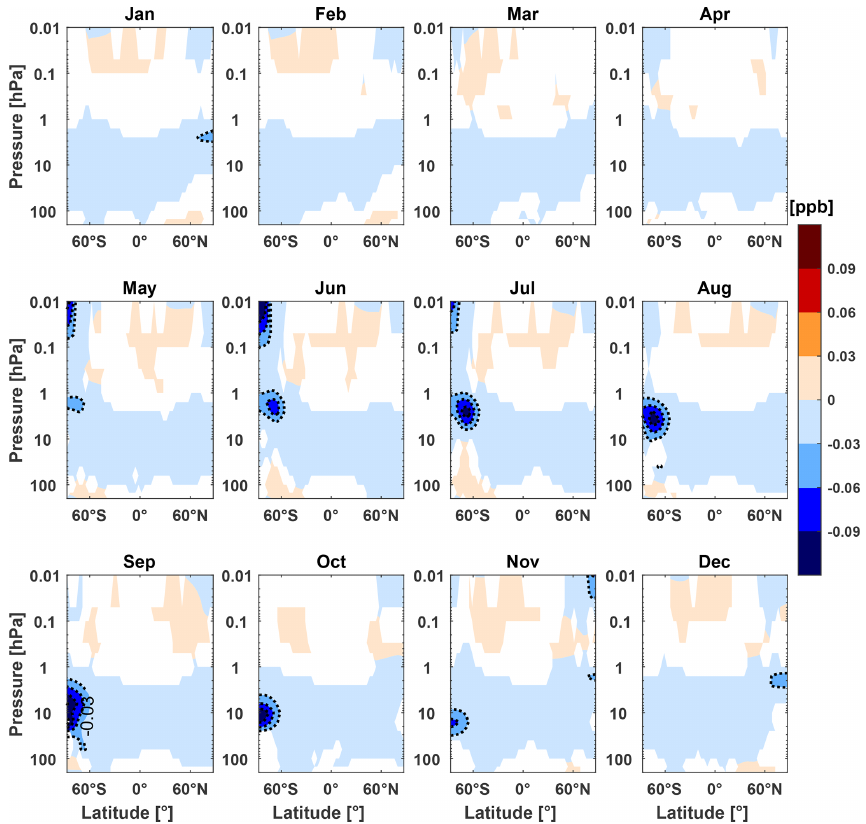
Figure 5. Absolute difference in the monthly zonal mean ClO between EXP and REF during 1979–2008. Negative contour levels are − 0 . 03, − 0 . 06 and − 0 . 09ppb. Colour shading indicates areas significant at the 95% level, calculated with a Monte Carlo simulation and a false detection